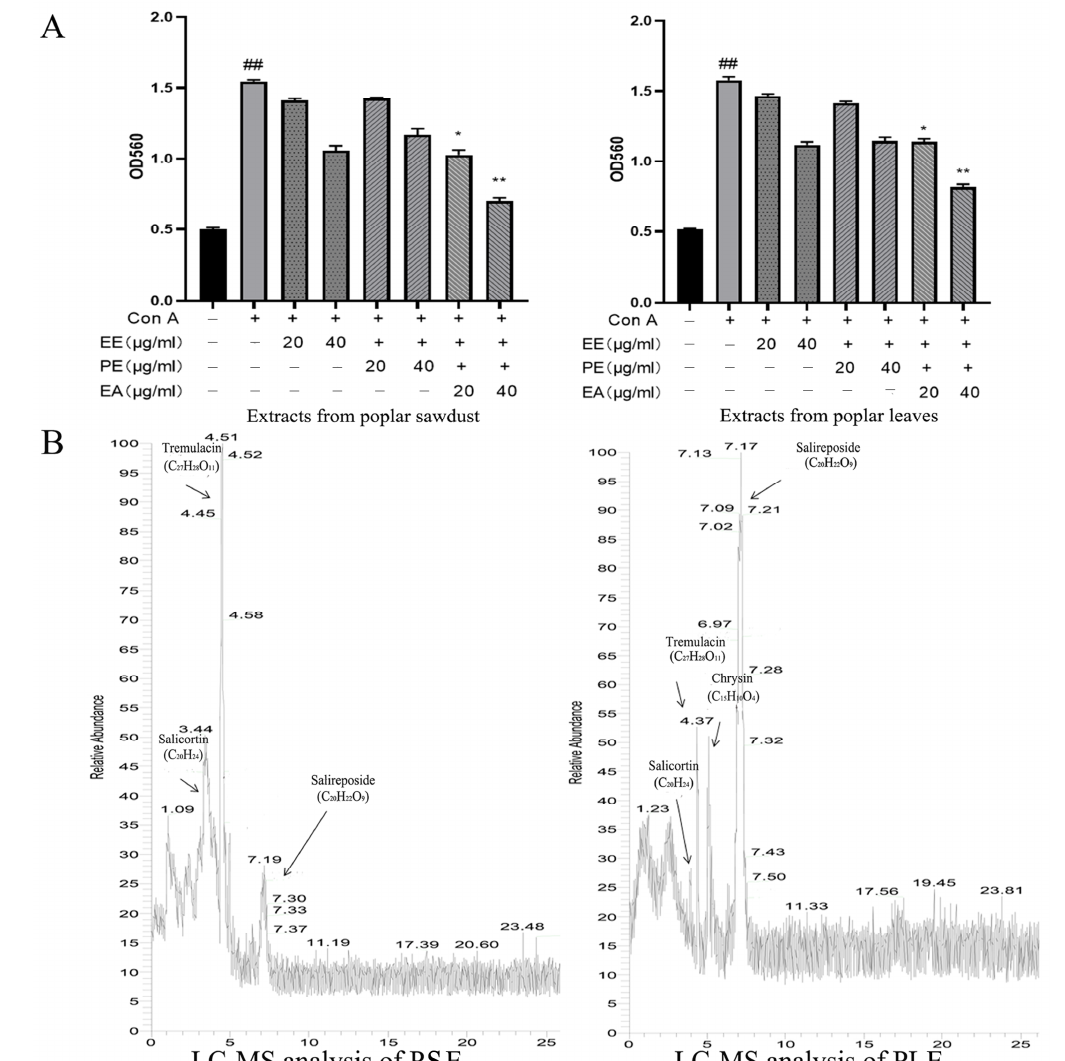
Figure 1. Extracts of poplar waste showed anti-inflammatory activity. ( A ) Three fractions were obtained from poplar sawdust and poplar leaves. Poplar sawdust (PS) and poplar leaves (PL) were extracted by ethanol and then extracted by petroleum ether and ethyl acetate. Extracts were divided into three groups: total ethanol extract (EE), petroleum ether extracted phase (PE) and ethyl acetate extracted phase (EA). The inhibition rates on the proliferation of Con A-activated lymphocytes were analyzed, both EA showed excellent anti-inflammation activity. Ethyl acetate extracted phase of PS was named PSE and ethyl acetate extracted phase of PL was named PLE. The inhibition rate of PSE was 80.6 ± 2.35%, PLE was 69.43 ± 1.4%. ( B ) LC-MS analysis of the components in the poplar extracts of PS and PL. Data are represented as mean ± SD, of three experiments n = 3. The “+” indicates that the substance was added, and the “–” indicates that the substance was not added. ## p < 0.01 vs. blank (Con A negative), * p < 0.05, ** p < 0.01 vs. Con A control.